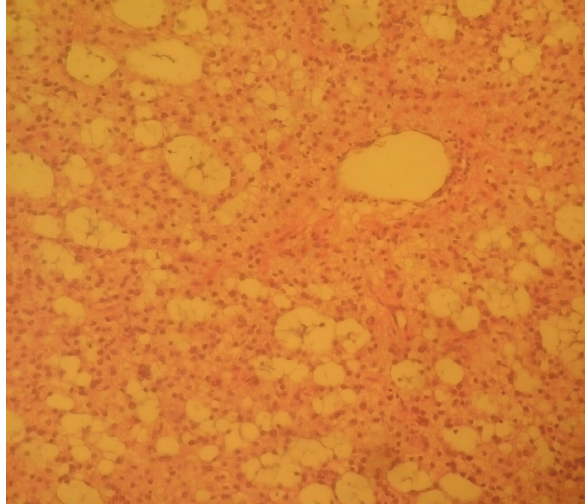
Figure 2A Squash Smear and 2B Tissue section of Transitional Meningioma showing spindle shaped cells having scant cytoplasm with elongated nuclei and inconscipious nucleoli along with meningothelial cells having round to oval nuclei. Psammoma bodies also seen.